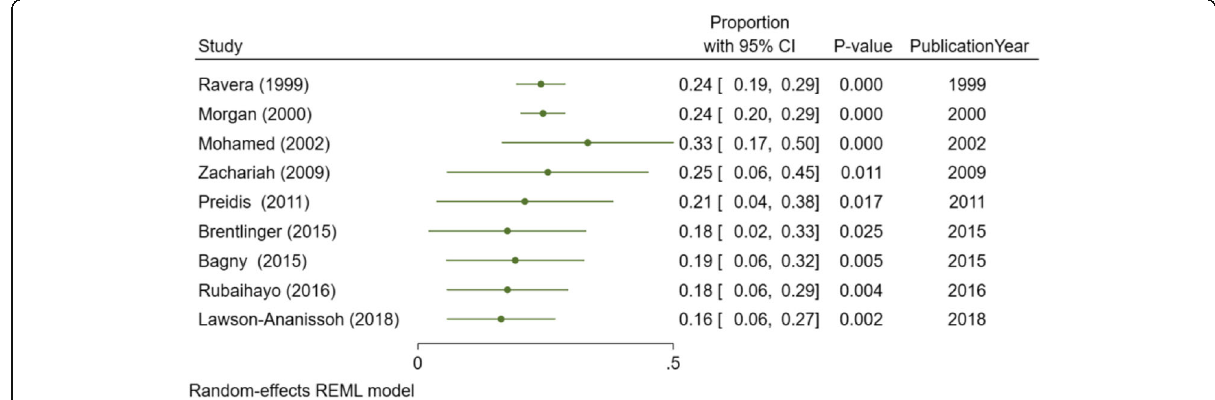
Fig. 5 Cumulative prevalence of esophageal candidiasis in HIV patients for the period 1994 to